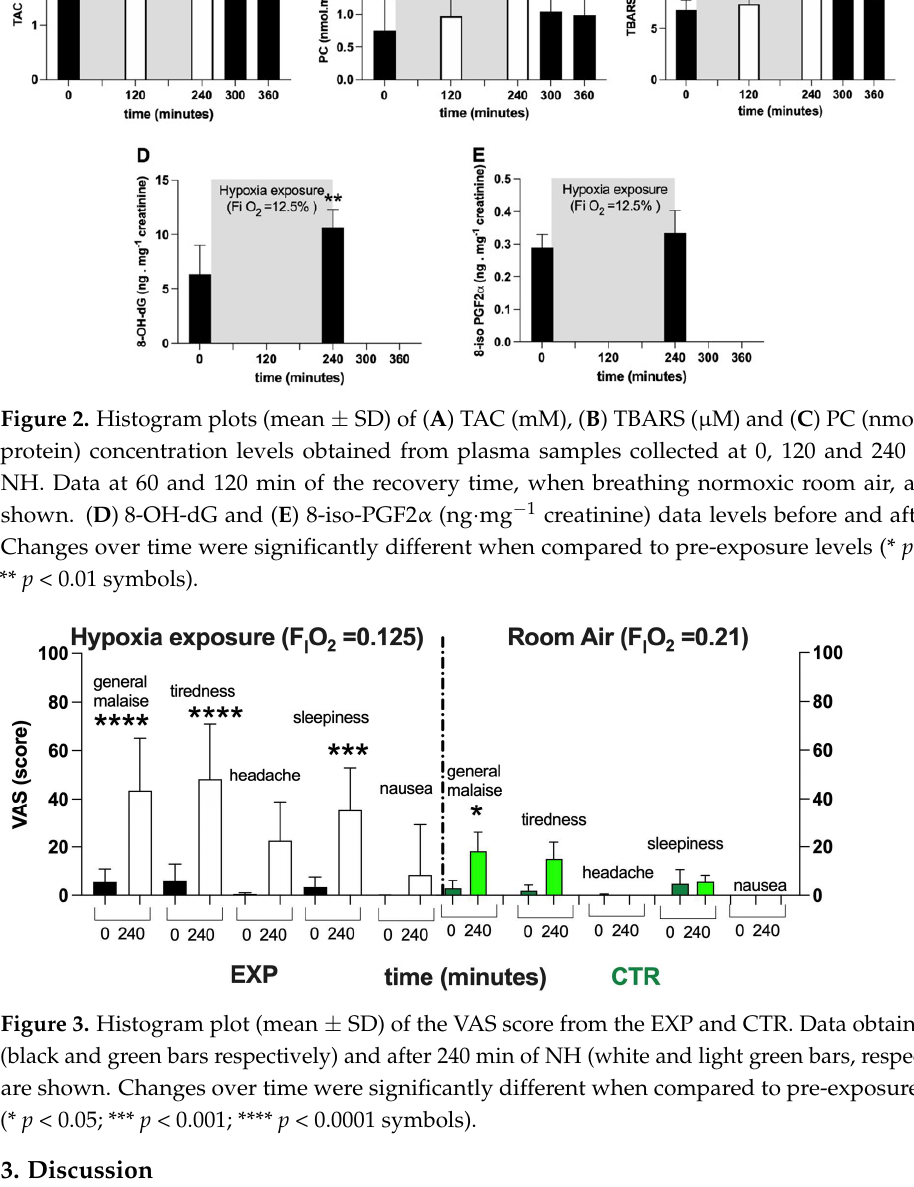
Figure 3. Histogram plot (mean ± SD) of the VAS score from the EXP and CTR. Data obtained Pre- (black and green bars respectively) and after 240 min of NH (white and light green bars, respec- tively) are shown. Changes over time were significantly different when compared to pre-exposure levels (* p < 0.05; *** p < 0.001; **** p < 0.0001 symbols).